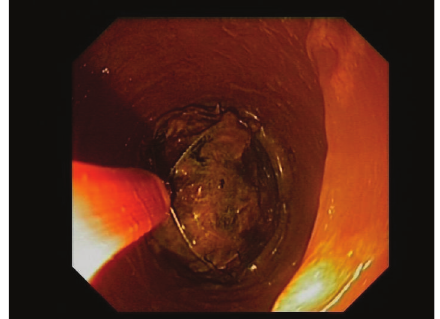
Figure 4: Gallstone into lithotripsy extraction